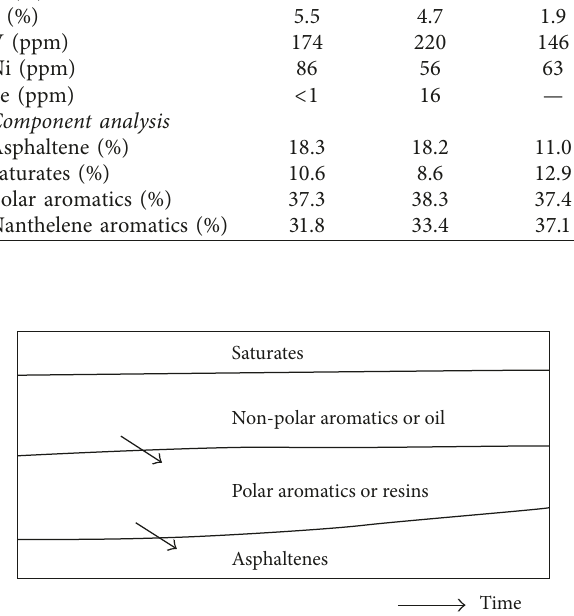
Figure 4: Effect of aging on the chemical composition of the asphalt (from Heneash